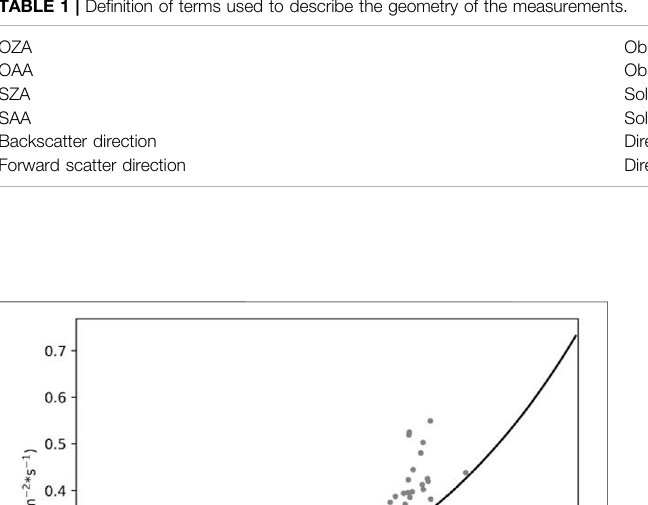
Frontiers in Earth Science |